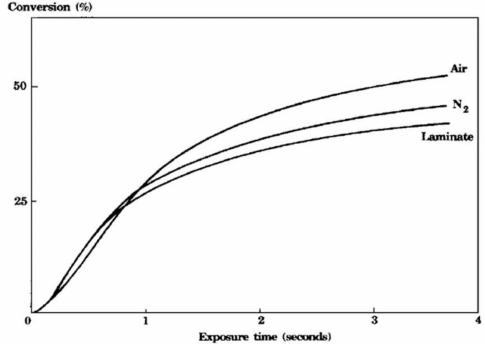
Figure 1. Conversion versus exposure time for the cationic photopolymerization of a cycloaliphatic diepoxy compound in the presence of air, in a N 2 -saturated atmosphere, and in the presence of air after covering with a transparent polyethylene film (laminate). Reprinted with permission of John Wiley and Sons from reference